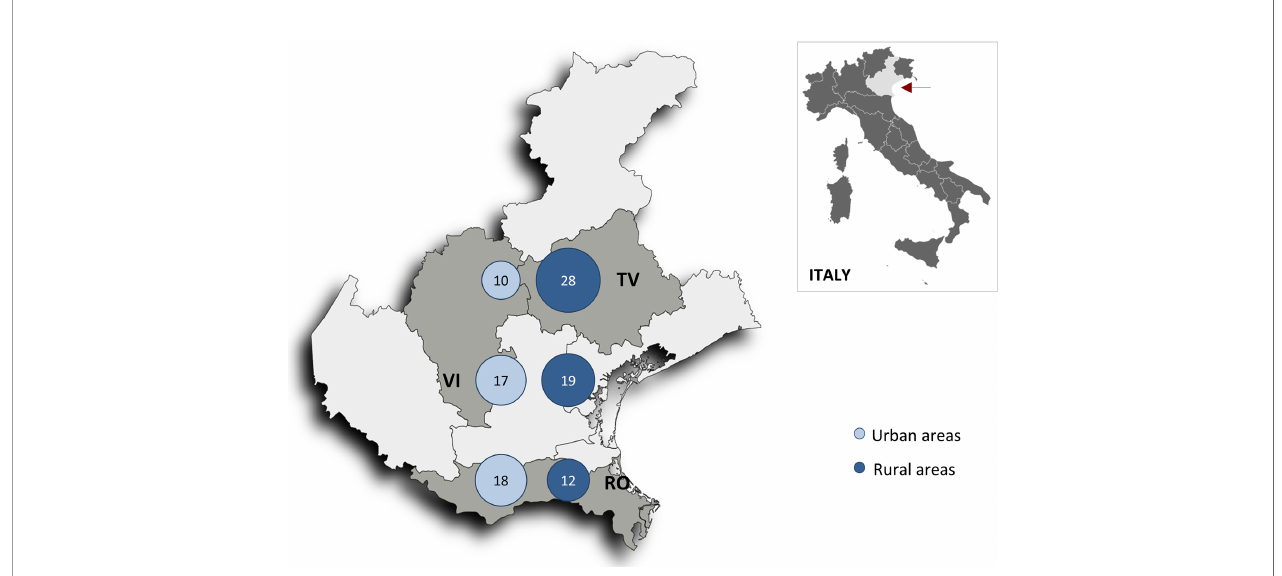
FIGURE 4 | Map of the Veneto region (red arrow) showing neoplastic death rates per 1000 person-years in the six geographic areas after excluding patients who had malignancy and still alive (n = 519 patients). RV, Rovigo province; TV, Treviso province; VI, Vicenza province.